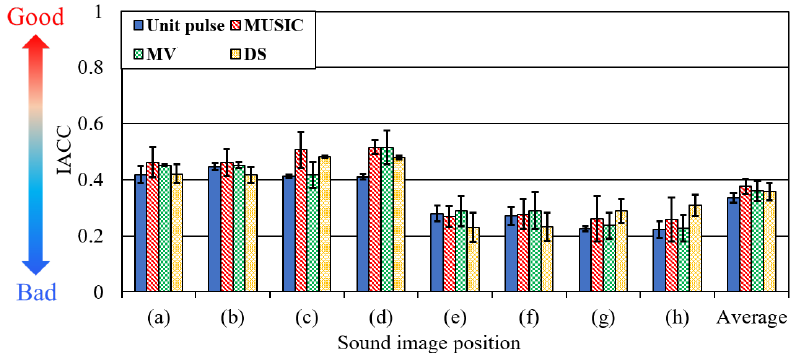
Figure 13. Generated directivities.